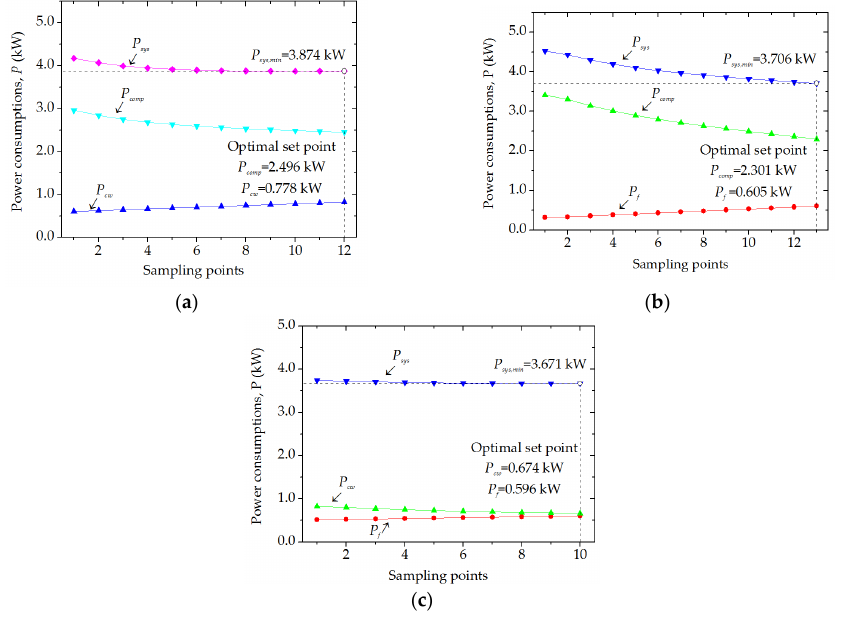
Figure 8. Two optimal controlled variables at a required cooling load of 12.24 kW: ( a ) compressor input power versus the input power of condenser water pump; ( b ) compressor input power versus fan input power; ( c ) fan input power versus the input power of condenser water pump.